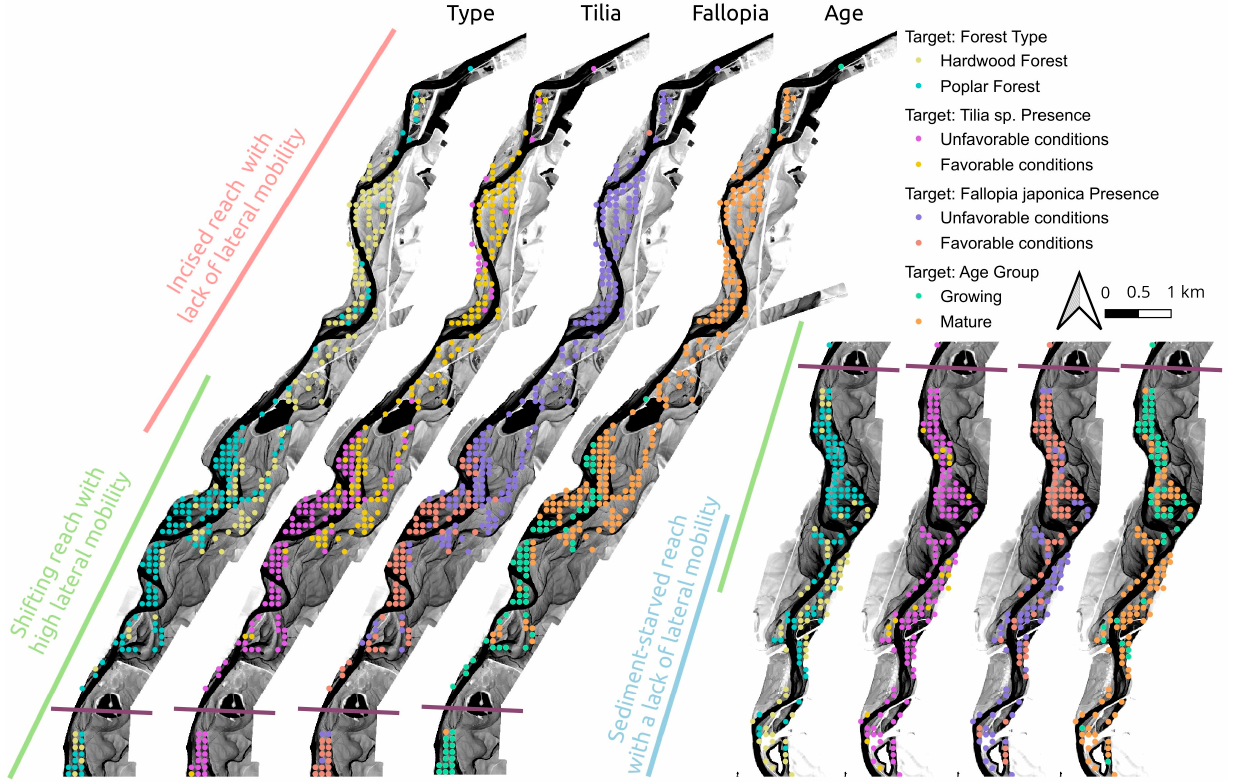
Figure 13. Spatial trends of riparian forest connectivity across the lower Ain River, according to the four random forest classifiers and their respective targets. (For coordinate references, see Figure 3 or Figure 14).